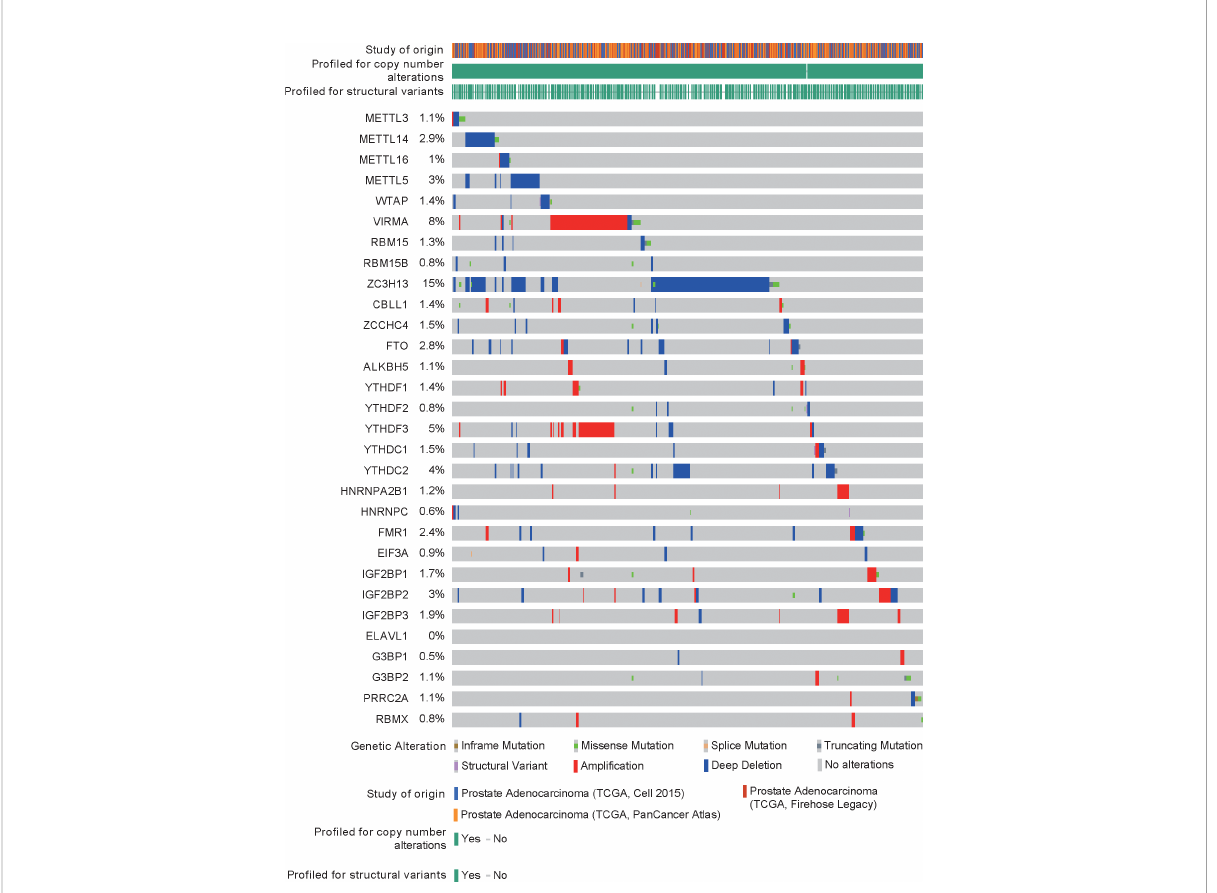
FIGURE 2 Gene mutations and copy number variants of RNA m6A regulators in prostate